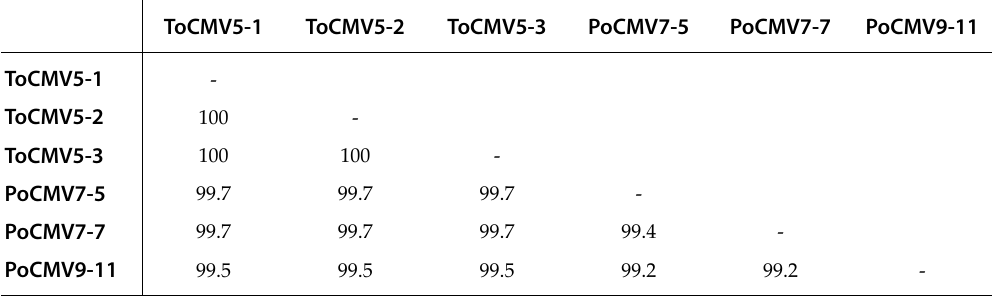
Figure 2. Maximum parsimony tree of the coat protein (CP) nucleotide sequences of CMV isolates. Percentage of boot- strap values in which each node was recovered is given when >70%. The tree was constructed using the CP nucleo - tide sequence of PSV as an outgroup. Syrian CMV isolates are shown in bold. Table 3. Nucleotide sequence comparison of the coat proteins of Syrian CMV isolates from potato and